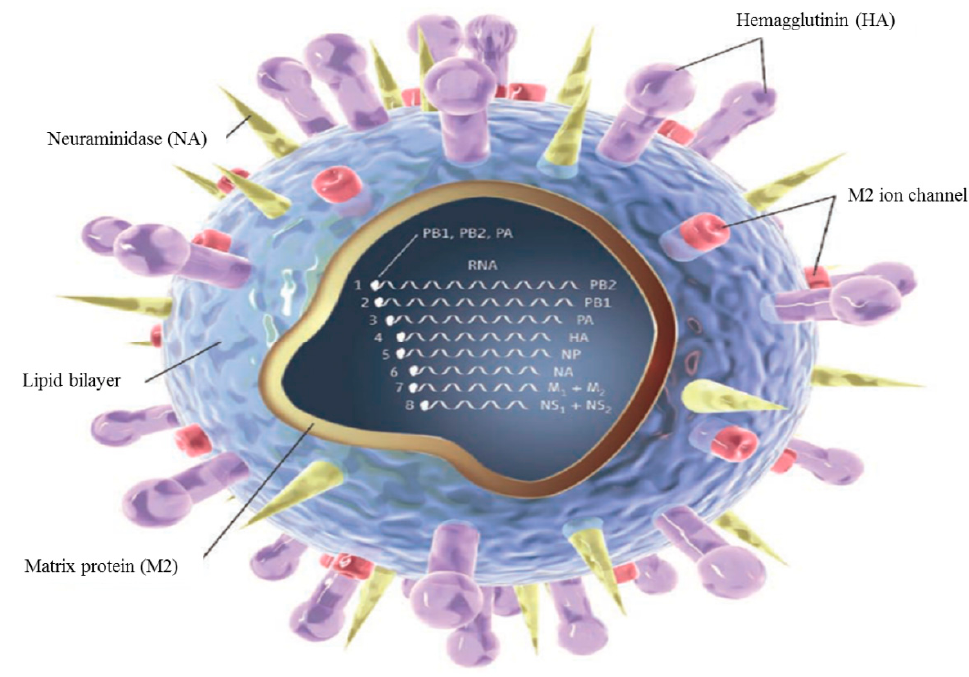
Figure 1. Structure of influenza virus.